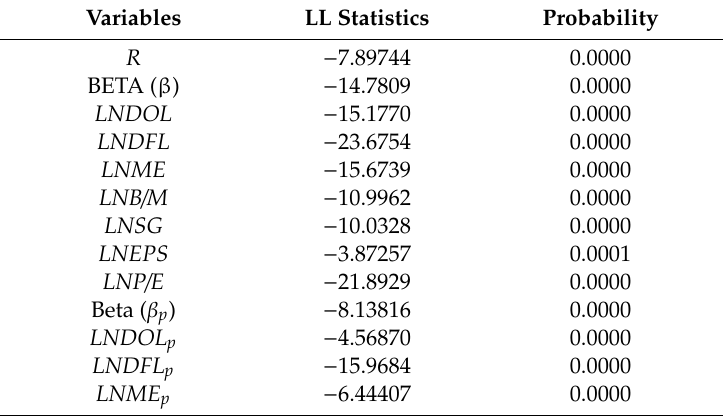
Table 3. Unit Root Test